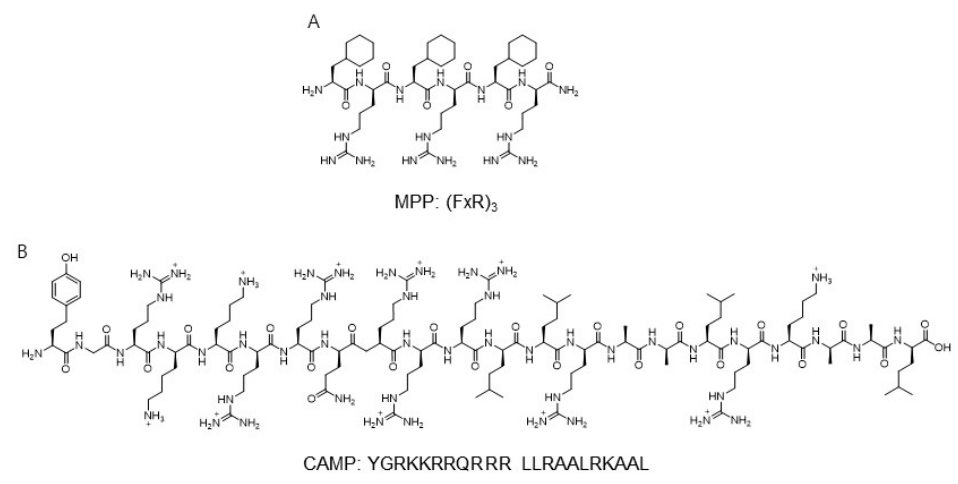
Figure 3. The sequence of mitochondria-targeting peptide MPP and CAMP [46,47]. Structures from